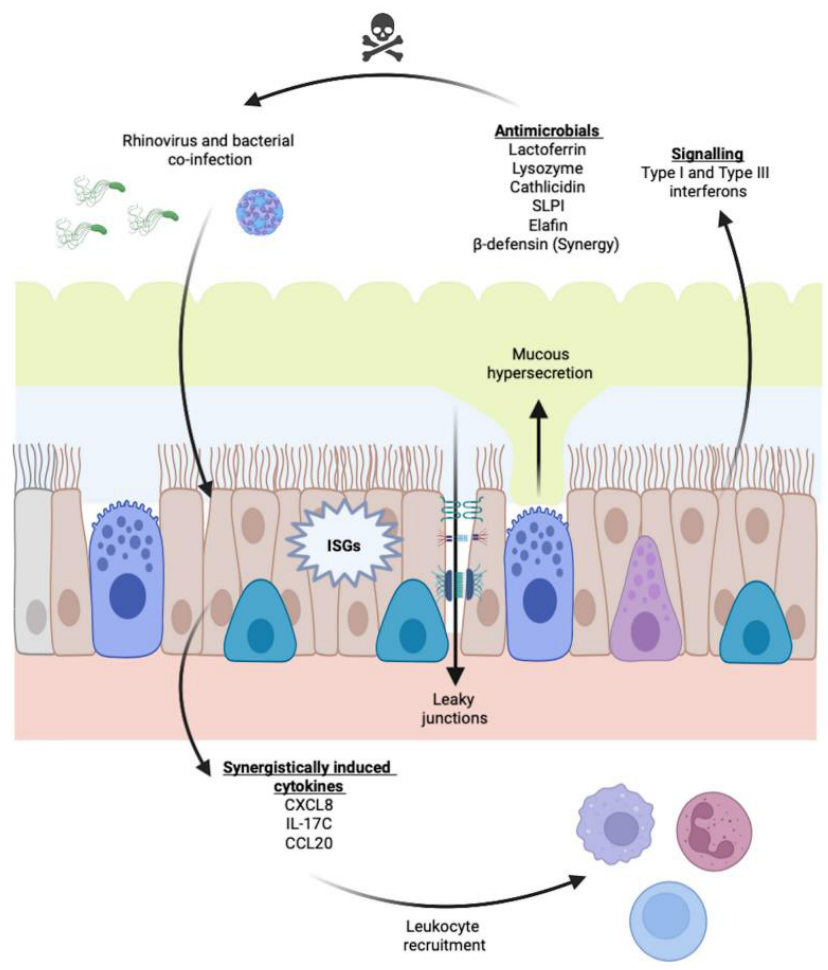
Figure 3. Airway epithelial responses to infection with viruses and/or bacteria. Epithelial cells produce intracellular and secreted antivirals and antibacterial products. In addition, chemokines and cytokines can be synergistically produced upon co-infection. There is also increased mucus secretion and a reduction in barrier function. ISGs, interferon-stimulated genes. Once both viruses and bacteria are present in the airway, they can interact to modify epithelial responses relative to those observed with each stimulus individually. It has been shown that rhinovirus and bacteria synergistically induce epithelial production of several molecules, including CCL20, human β -defensin-2 (HBD2) and IL-17C [121 – 123]. These molecules are induced by synergistic effects on several signaling pathways. Interestingly, the antibacterial molecule HBD2 is produced in significantly lower amounts in epithelial cells from patients with COPD compared to those from smokers with normal lung func- tion or from healthy controls [122]. By contrast, IL-17C, which feeds back on epithelial cells to stimulate production of the proinflammatory chemokine CXCL1, inducing neu- trophil chemotaxis, is produced in increased amounts in response to virus and bacteria in cells from COPD patients compared to other groups [123]. It is tempting to speculate that